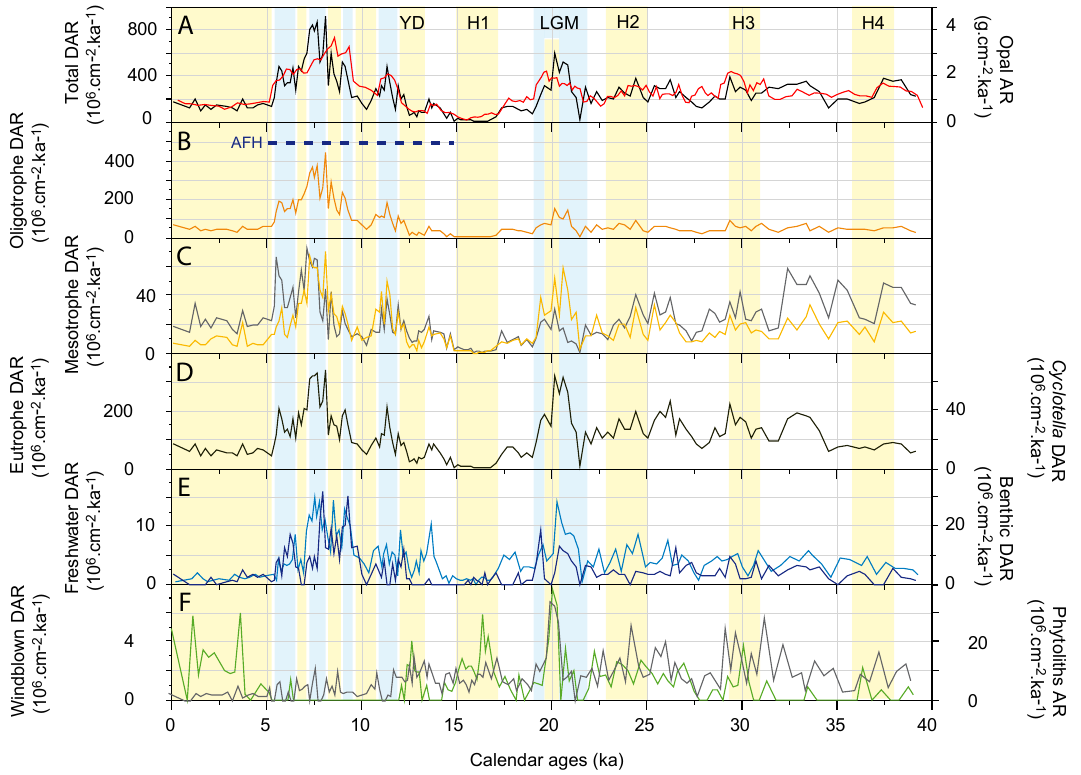
Fig. 3. Accumulation rates of diatoms and opal in core GeoB4905-4 versus calendar ages. (A) Total diatom accumulation rates (black line) and opal accumulation rates (red line), (B) accumulation rates of oligotrophe diatoms, (C) accumulation rates of mesotrophe diatoms (yellow line) and Cyclotella spp. (grey line), (D) accumulation rates of eutrophe diatoms, (E) accumulation rates of freshwater diatoms (light blue line) and benthic diatoms (dark blue line) and, (F) accumulation rates of Aulacoseira spp. (green line) and opal phytoliths (grey line). Blue and yellow shading represents periods of inferred high precipitations and low precipitations over western Africa,